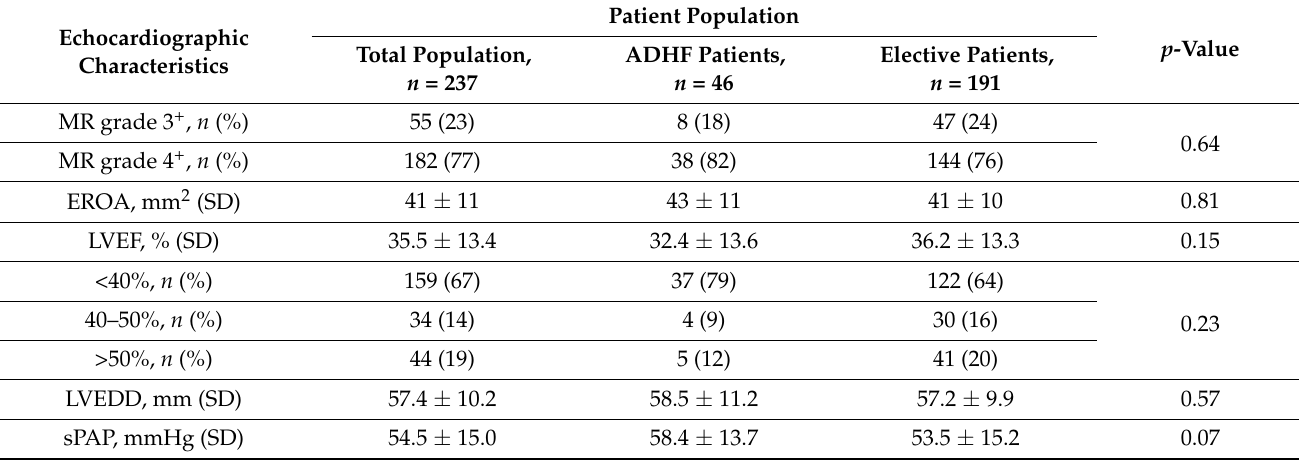
Table 2. Baseline echocardiographic characteristics of patient population before PMVr.